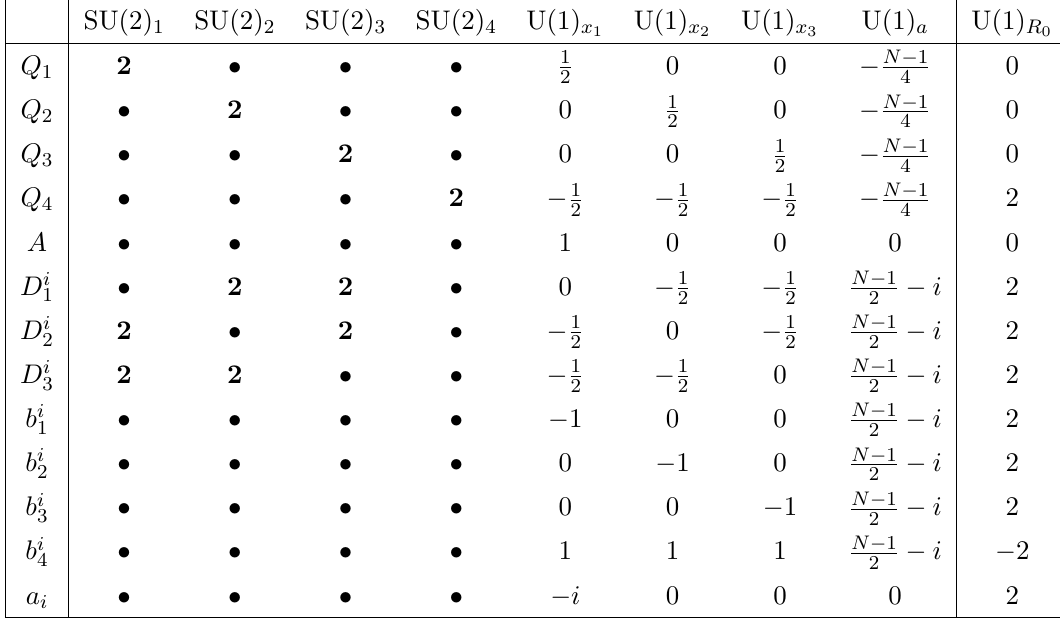
Table 2 . The representations of the chiral fields under the symmetry groups for higher rank